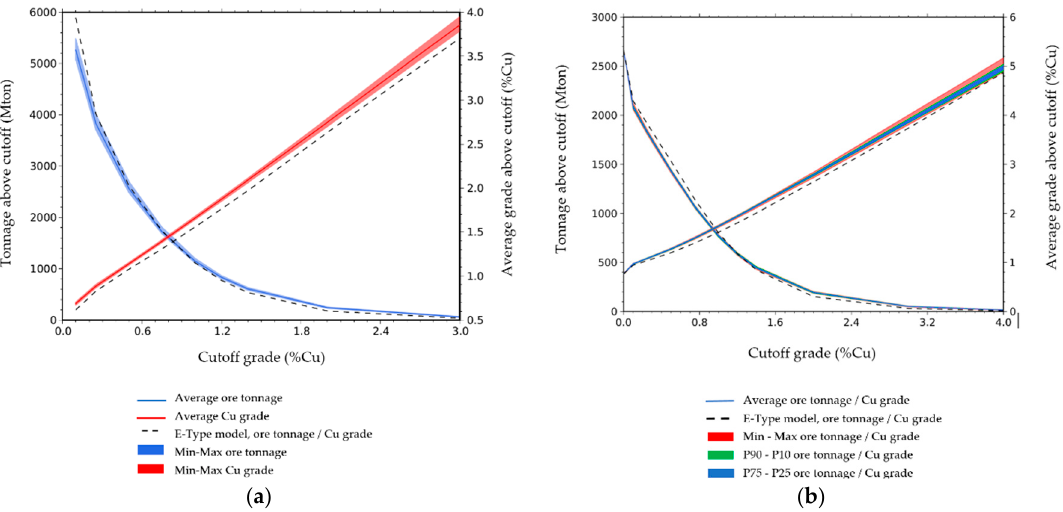
Figure 10. Grade-tonnage curve for estimated (E-Type) and simulated models, when considering ( a ) total resources, and ( b ) economic reserves within optimal ultimate pit limits defined for Scheme 2.